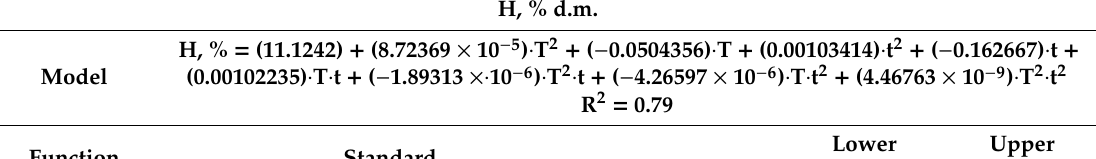
Table A7. The statistical parameters of polynomial regression analysis of the influence of SS torrefaction temperature and residence time on the H content in